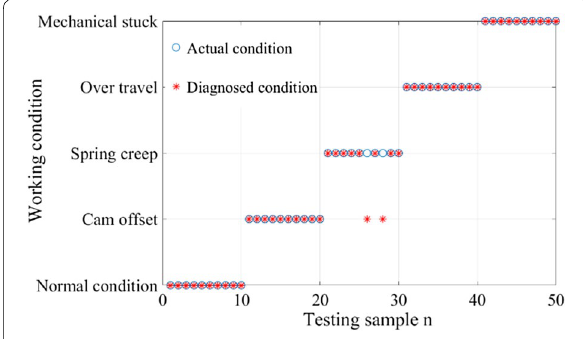
Figure 8 Fault diagnosis result of